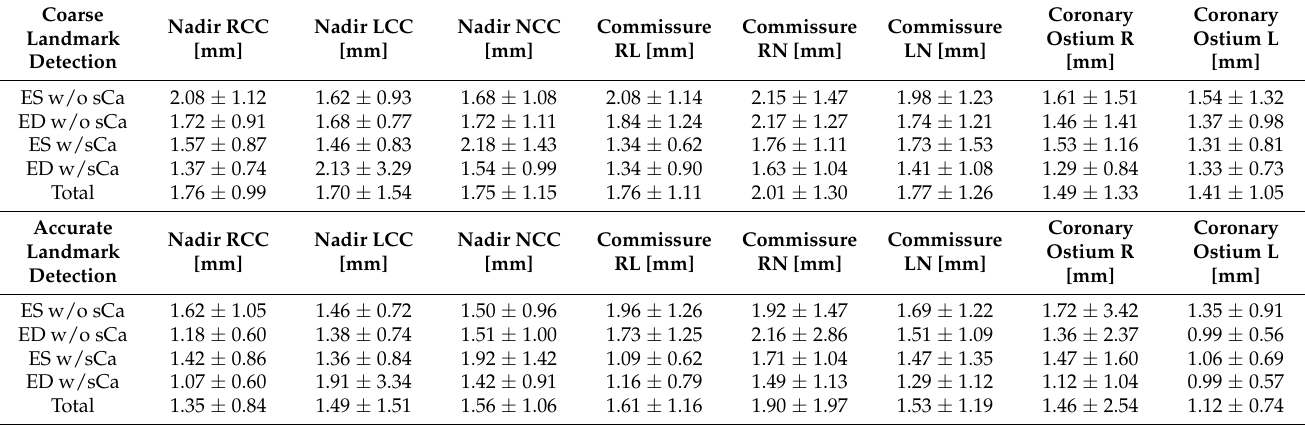
Table 1. Landmark Detection Results.